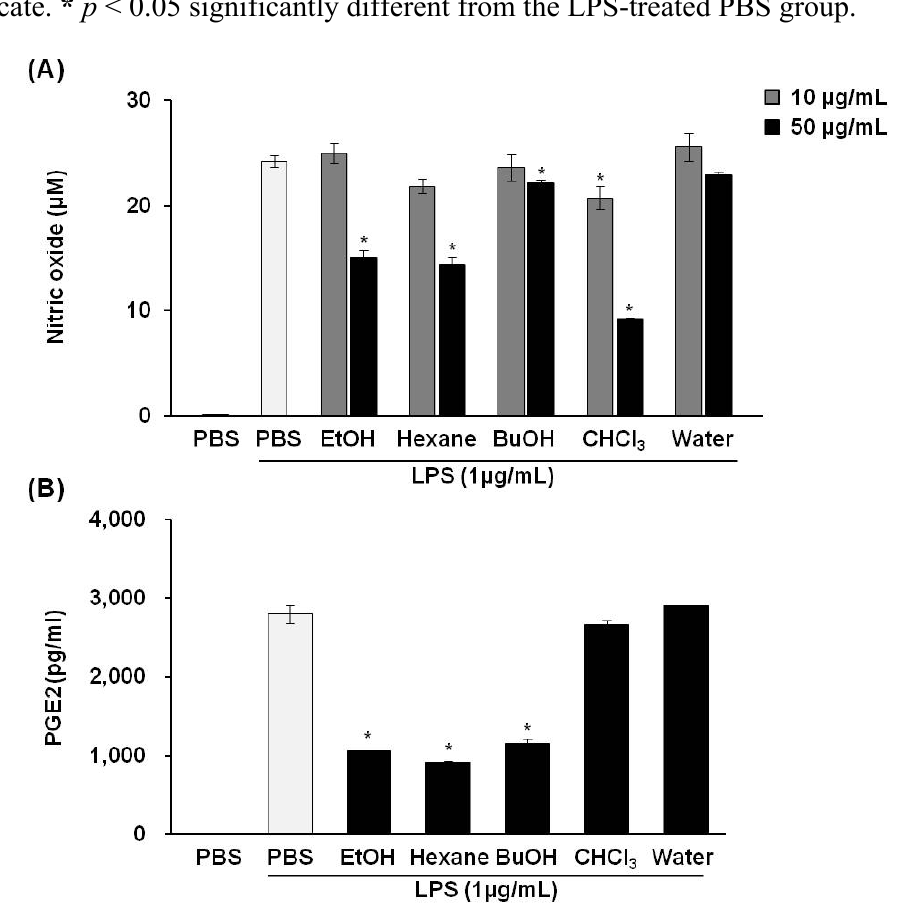
Figure 2. Effects of the solvent fractions from Prunella vulgaris var. lilacina on LPS-induced nitric oxide (NO) ( A ) and prostaglandin E2 (PGE2); ( B ) production in RAW 264.7 cells. Values show the means and standard deviations of three different experiments performed in triplicate. * p < 0.05 significantly different from the LPS-treated PBS